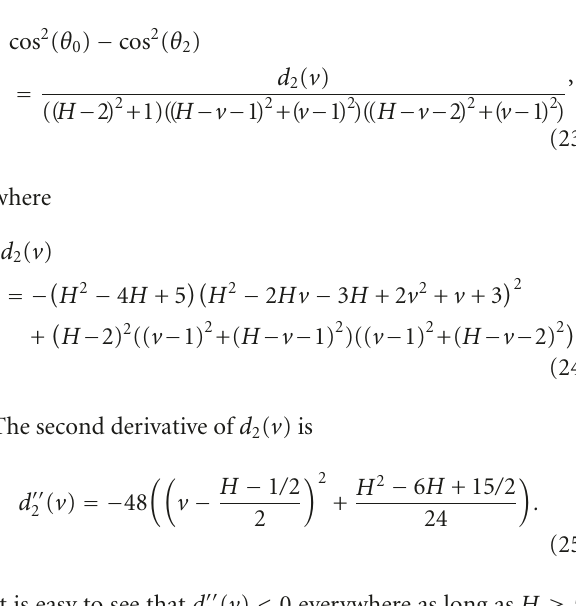
Figure 5: Envelope of nodes vwi to a source for finite beamwidth. Only the nodes inside the envelope can be vwi to the node in the origin.